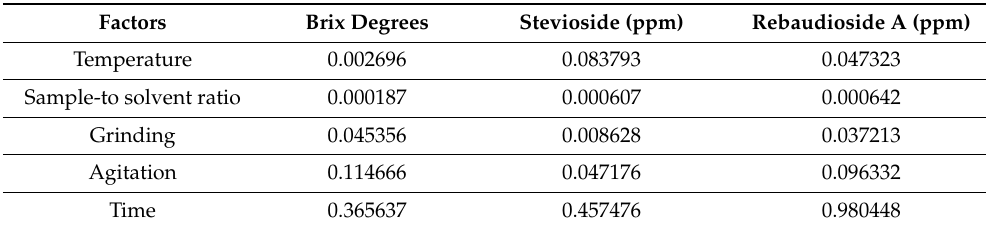
Table 2. Analysis of variance ( p -value) for the dependent variables considered in the factorial screening